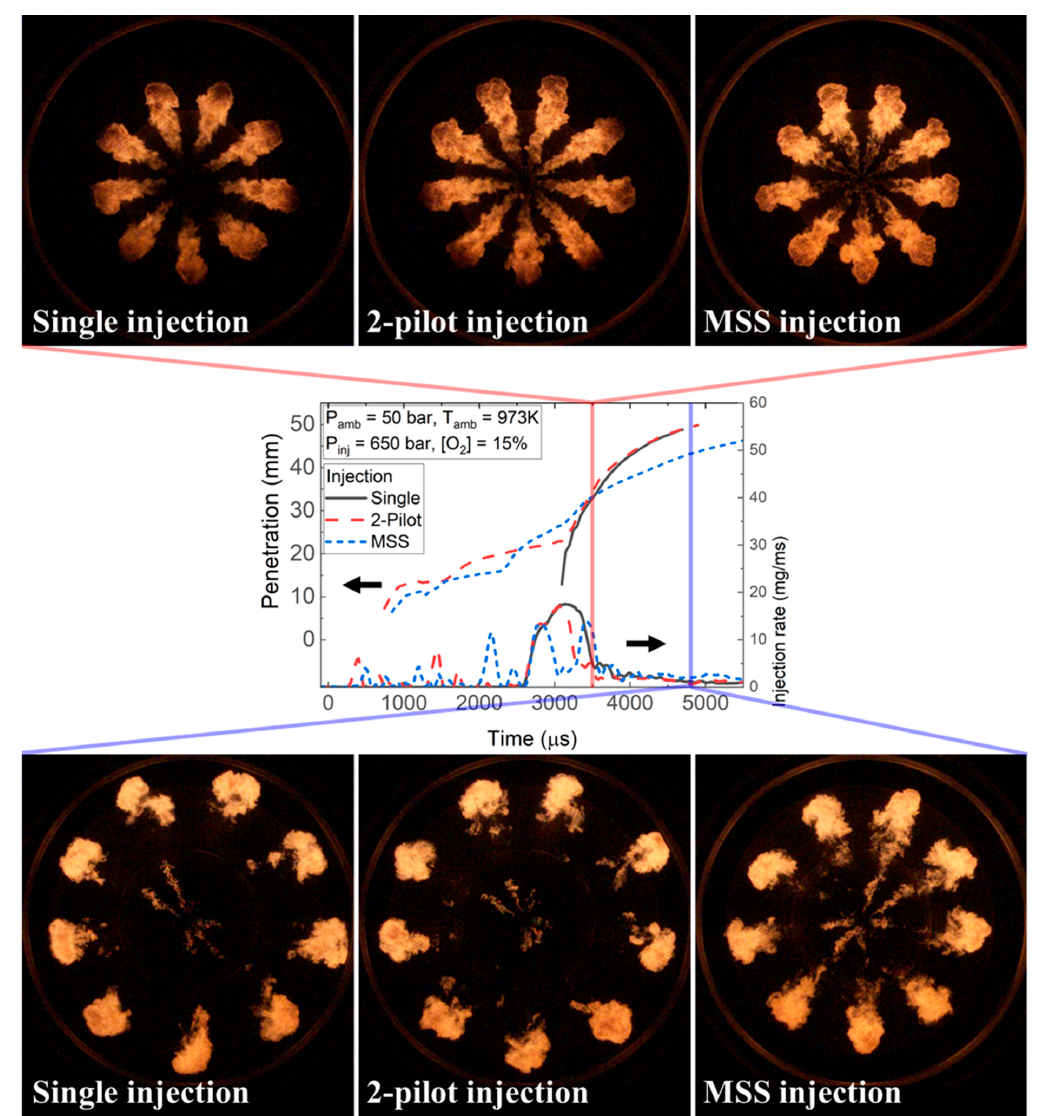
Figure 11. Flame visualization images at ( upper ) 3500 and ( lower ) 4800 μ s, based on two-pilot injection signal starts.